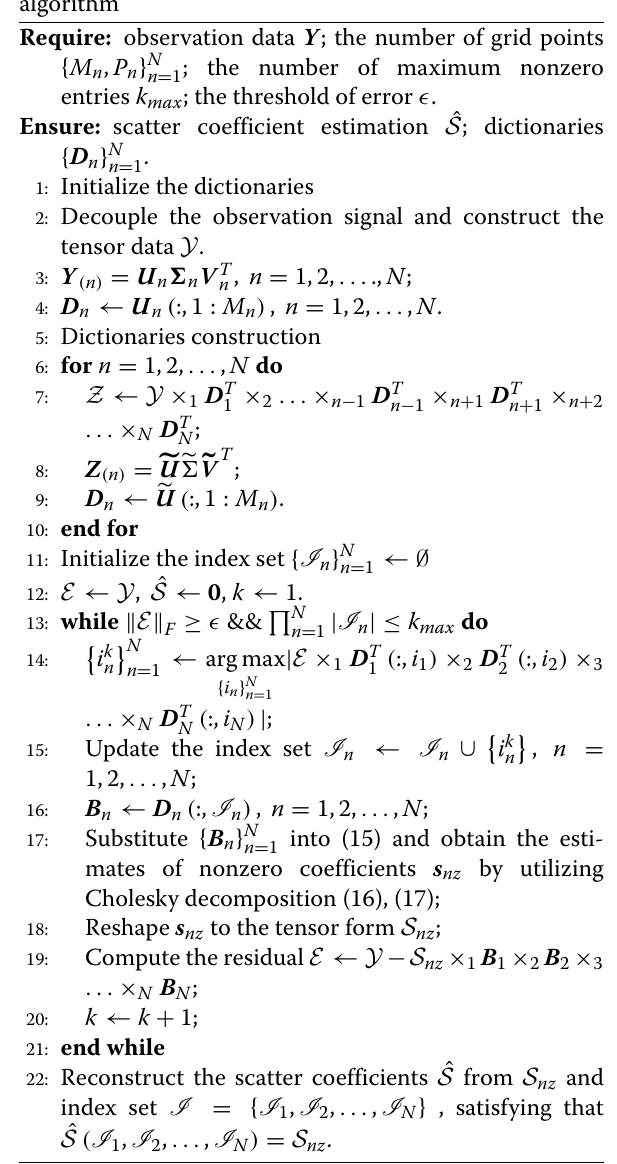
Algorithm 1 Higher-order SVD-based SAR imaging